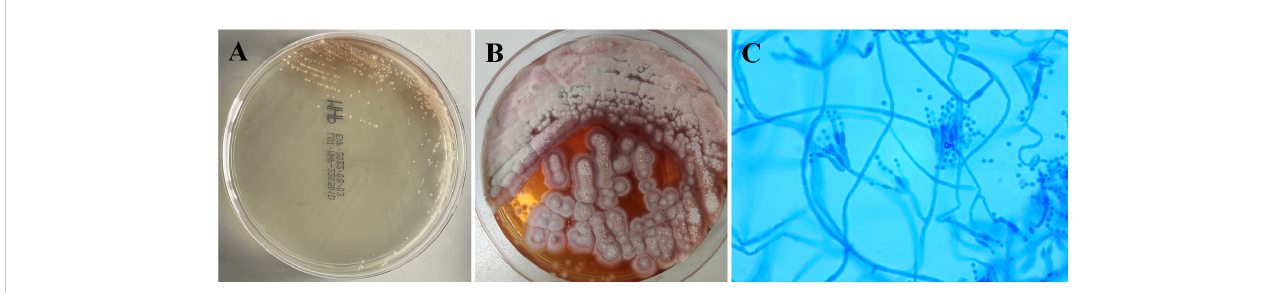
FIGURE 2 Culture results of this patient. (A) Blood culture on Sabouraud ’ s agar medium plate at 37°C showed yeast phase. (B) Blood culture of Talaromyces marneffei in the mold phase at 25°C, characteristic red pigment production was observed. (C) Lactophenol cotton blue staining from fungal blood culture demonstrating septate hyphae and smooth conidia aloft phialides, which are borne to